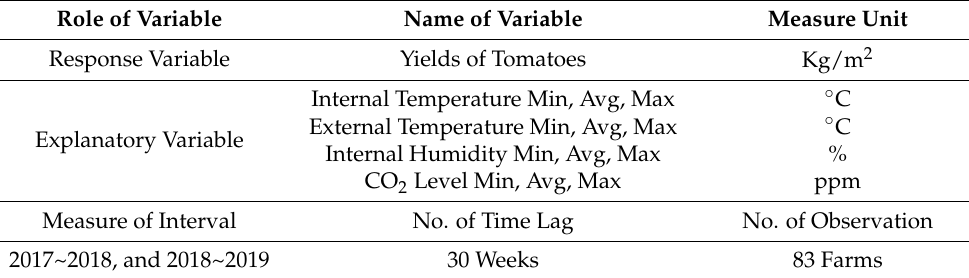
Table 1. Information of collected exogenous variables for tomatoes.